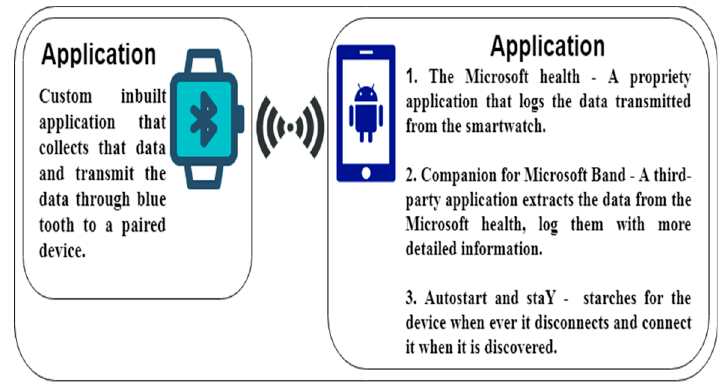
Figure 3. A high-level view of the system used, comprising a smartwatch and smartwatch.